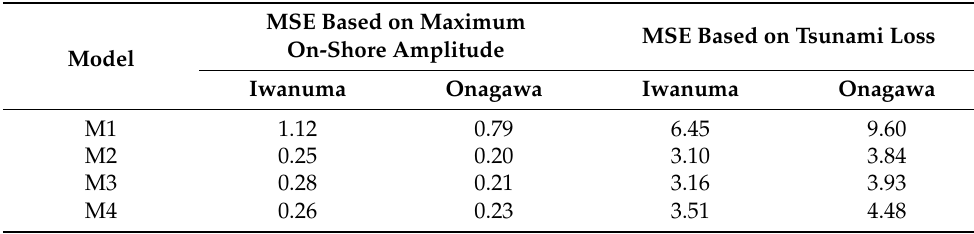
Figure 10. Spatial maps of sensors for the hazard-based early warning in Iwanuma: ( a ) 5 min, ( b ) 10 min, and ( c ) 20 min. The pink star represents the target location (Iwanuma). The red and empty circles represent the selected and unselected sensors, respectively. Table 1. Summary of the model performances of the hazard-based and risk-based early warning systems for Iwanuma and Onagawa. The values shown in the table are MSE based on the maximum on-shore wave amplitude (hazard-based) and the tsunami loss (risk-based).